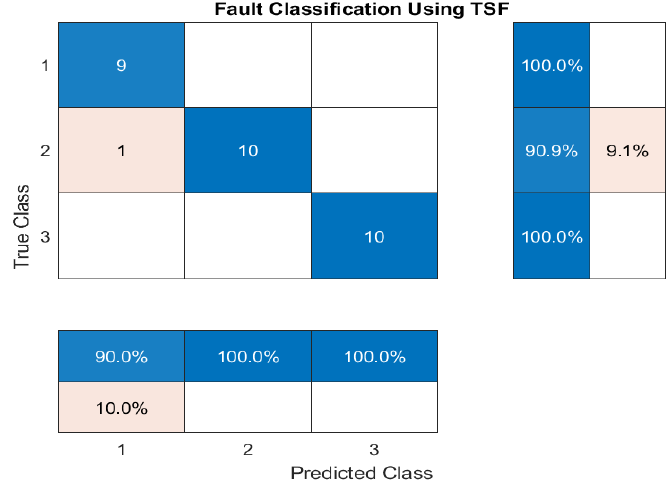
Figure 8. Confusion Matrix for TSF Univariate Model. Table 8. TSF Univariate Performance.